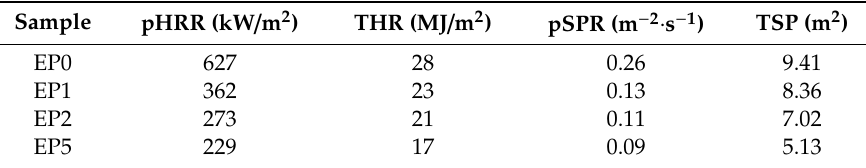
Table 3. Cone calorimetry test data of the